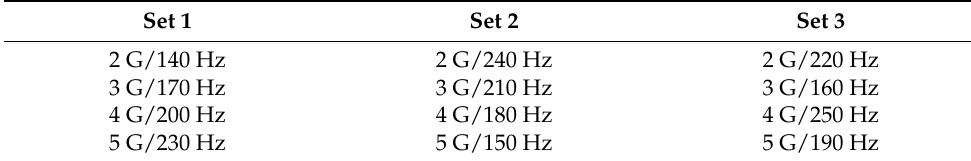
Table 4. New haptic signal settings in the experiment. Set 1 Set 2 Set 3